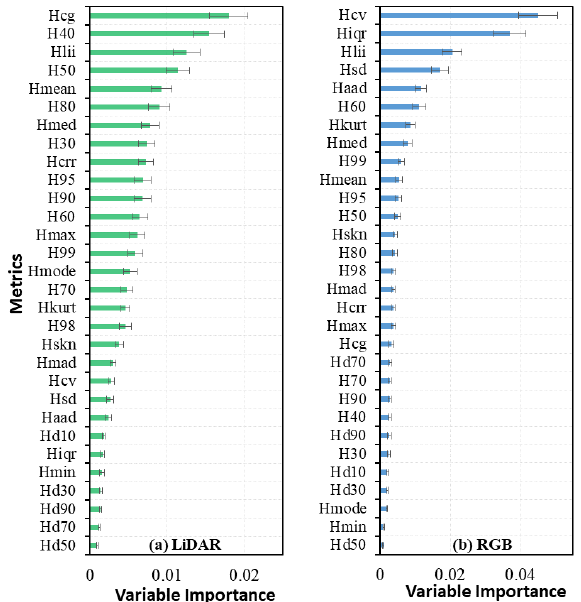
Figure 10. Ranking of height metrics in LAI estimation based on permutation variable importance of